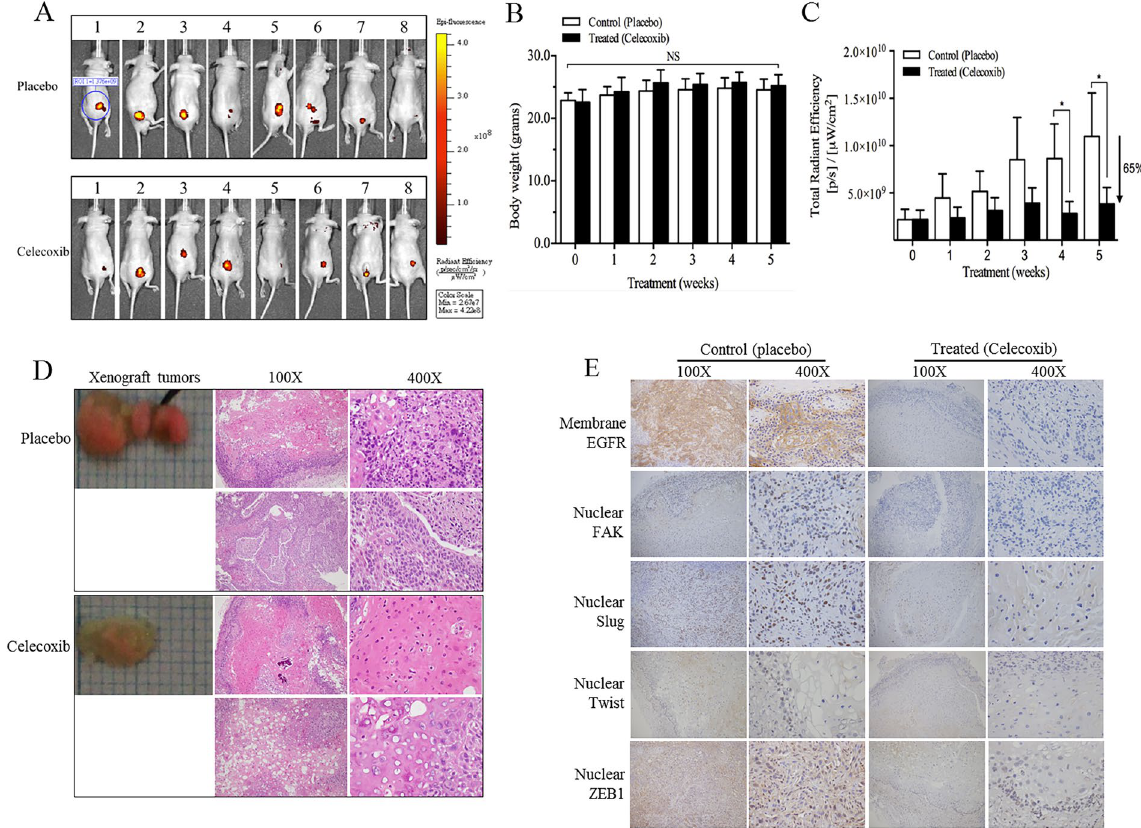
Figure 3. Effect of CXB in a murine xenograft model of OSCC. ( A ) The fluorescence signal of xenografted mice after 5-week treatment of CXB and placebo, respectively, was determined using an IVIS 2000 system. ( B ) Comparison of the murine body weight between CXB and placebo treatments. ( C ) Inhibition of xenograft tumour growth in the CXB-treated group compared with the placebo group. ( D ) Histological grade of excised xenograft tumours between CXB and placebo treated mice. ( E ) Measurement of the expression level of membrane EGFR and nuclear FAK, Slug, Twist and ZEB1 by IHC analysis (also refer Table